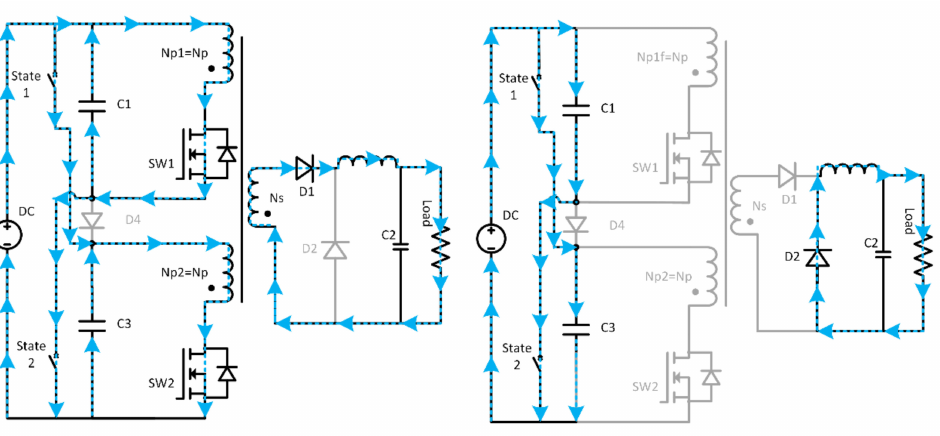
Figure 5. DVFW current loop at low line during ( left ) primary ON time and ( right ) OFF